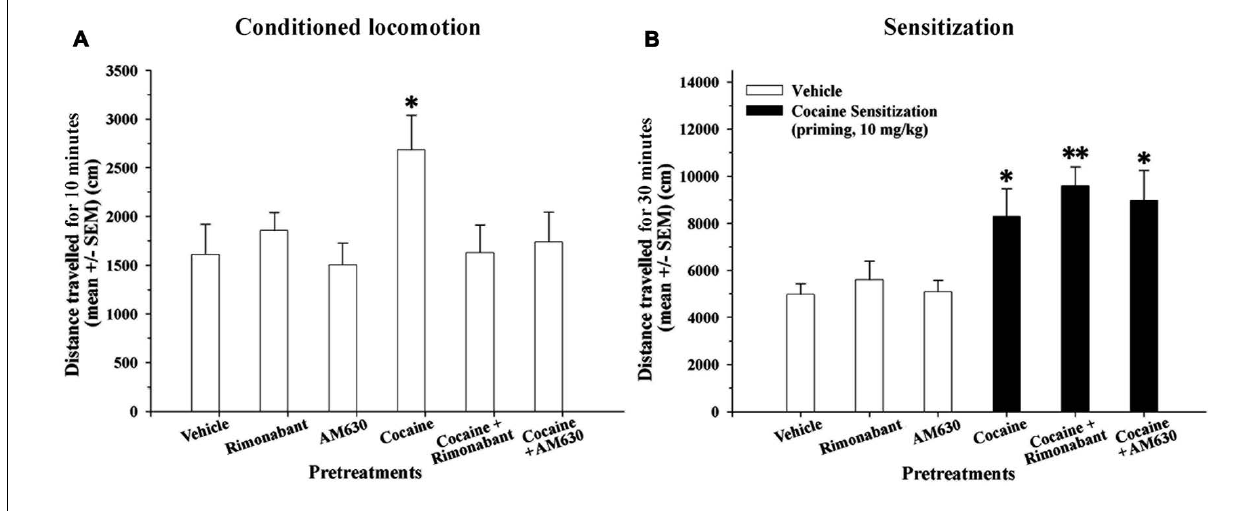
FIGURE 3 | (A) Effects of repeated administration of cocaine and co-administration of cocaine (20 mg/kg) and Rimonabant (3 mg/kg) or AM630 (3 mg/kg) on the conditioned locomotion response measured in the OF test. Five days after the final cocaine injection, only the cocaine-treated group exhibited elevated conditioned locomotion responses compared to the vehicle group ( ∗ P < 0.05) after a vehicle injection. (B) Effects of repeated administration of cocaine and co-administration of cocaine (20 mg/kg) and